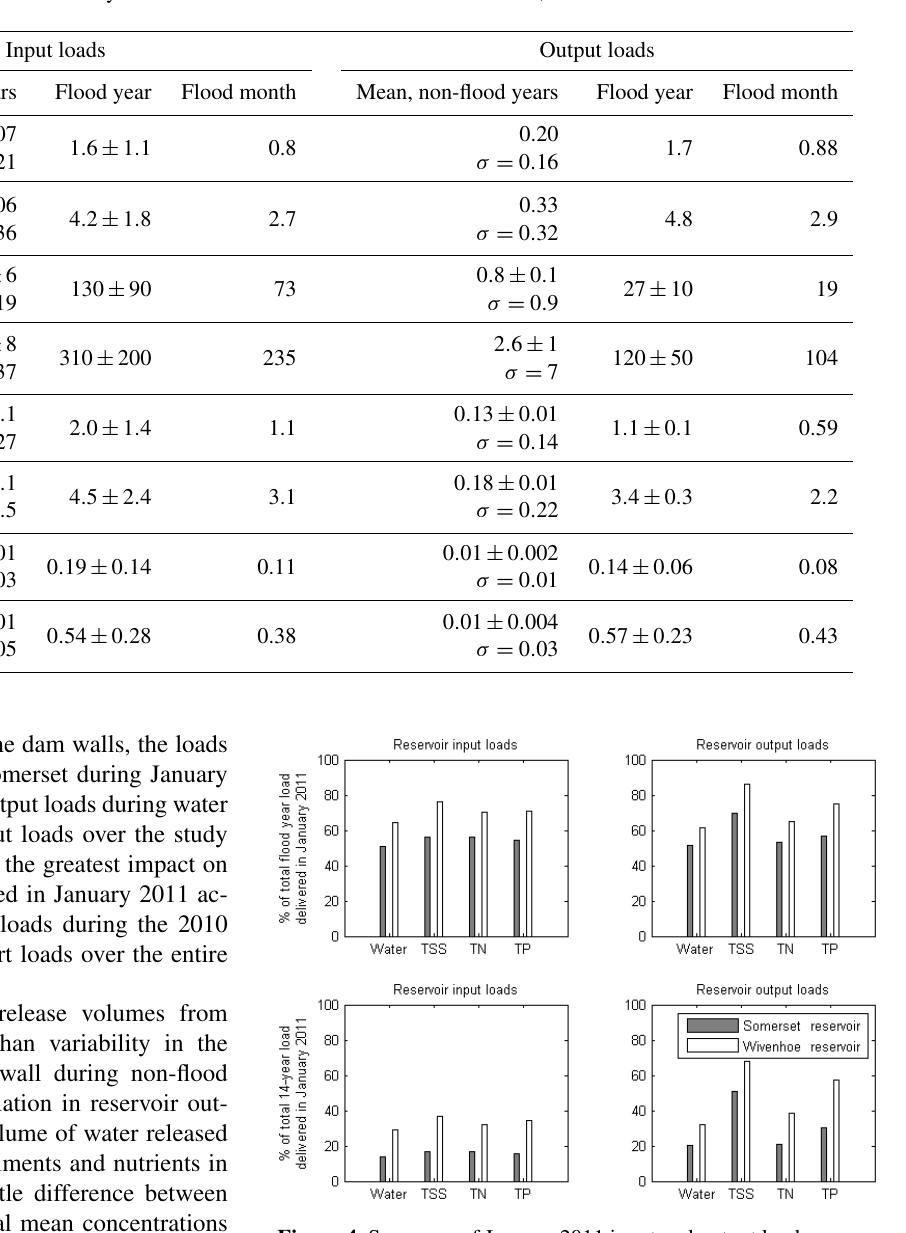
Figure 4. Summary of January 2011 input and output loads, as per- centage of total loads in and out during the flood year, and across the entire study